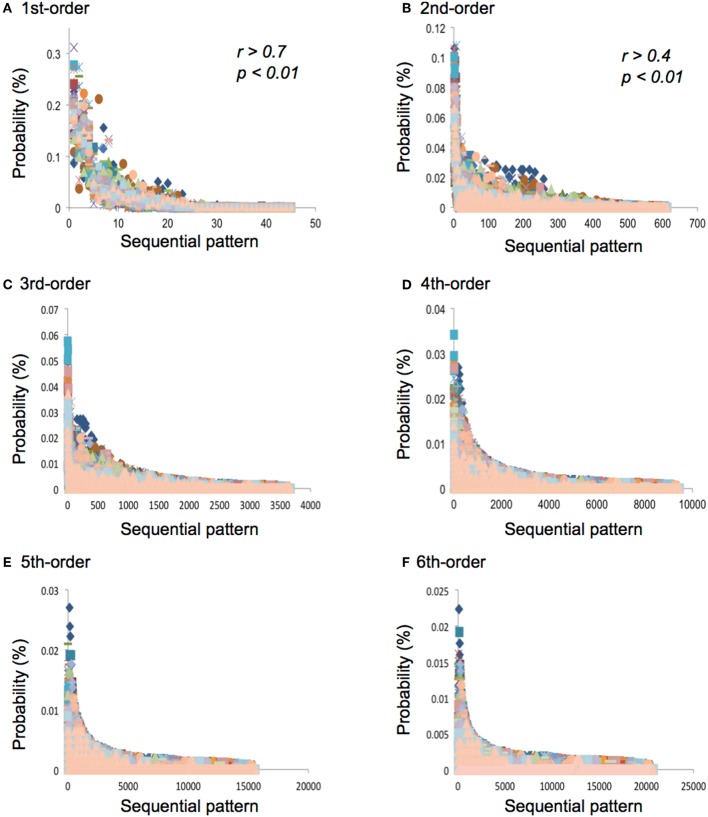
(A) The first-, (B) second-, (C) third-, (D) fourth-, (E) fifth-, and (F) sixth-order TPs in each sequential pattern. The horizontal and vertical axes represent sequential patterns and the TPs, respectively. The sequential patterns were arranged in descending order in each hierarchy.